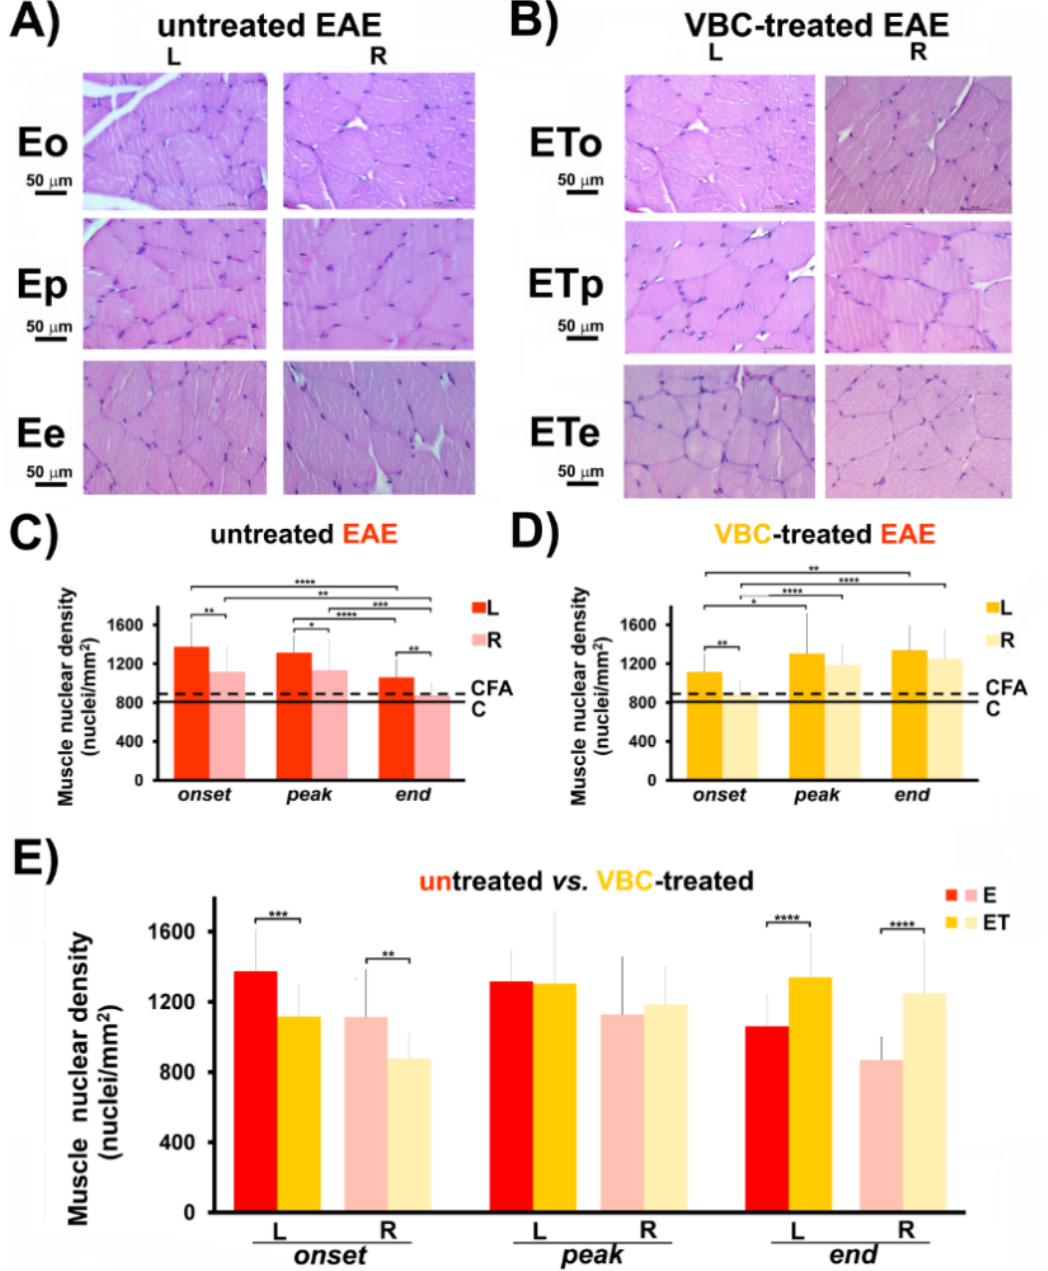
Figure 5. The effects of VBC treatment on muscle nuclear density during EAE. ( A ) Histological changes of muscle nuclear density in untreated EAE rats ( E ). Scale bar 50 µ m (Magnification 40 × ). ( B ) Histological changes of muscle nuclear density in VBC-treated EAE rats ( ET ). Scale bar 50 µ m (Magnification 40 × ). ( C ) Changes in muscle nuclear density in untreated EAE rats ( E ). ( D ) Changes in muscle nuclear density in VBC-treated EAE rats ( ET ). ( E ) Changes in muscle nuclear density compared in both groups ( E and ET ). The nuclear density is monitored in three different time points: onset ( o ), peak ( p ), and end ( e ) of the disease. Control intact rats ( C ), rats s.c. injected only with Complete Freund’s adjuvant ( CFA ). Left ( L ) and right ( R ) muscle. Results are presented as the mean ± standard error (SE). **** p < 0.0001; *** p < 0.001; ** p < 0.01; * p < 0.05.